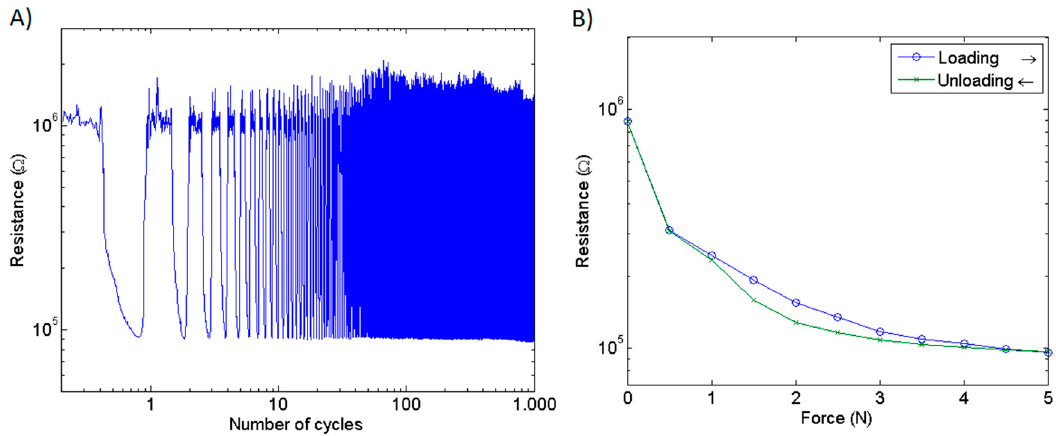
Figure 6. ( A ) Response of a single sensel to a 5 N load over 1000 cycles; and ( B ) typical loading-unloading curve of a single sensel.